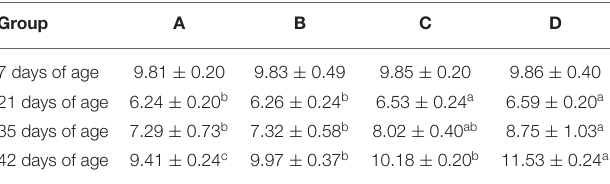
TABLE 6 | Serum NDV antibody levels of yellow-feathered chickens in different treatment